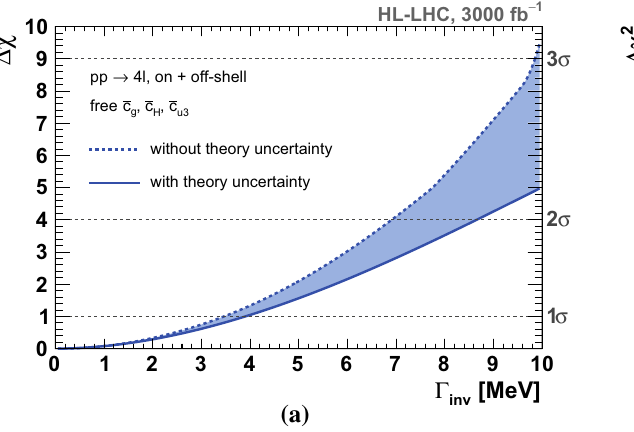
through signal-strength measurements only (blue line) and through differential p H h -dependent uncertainties T